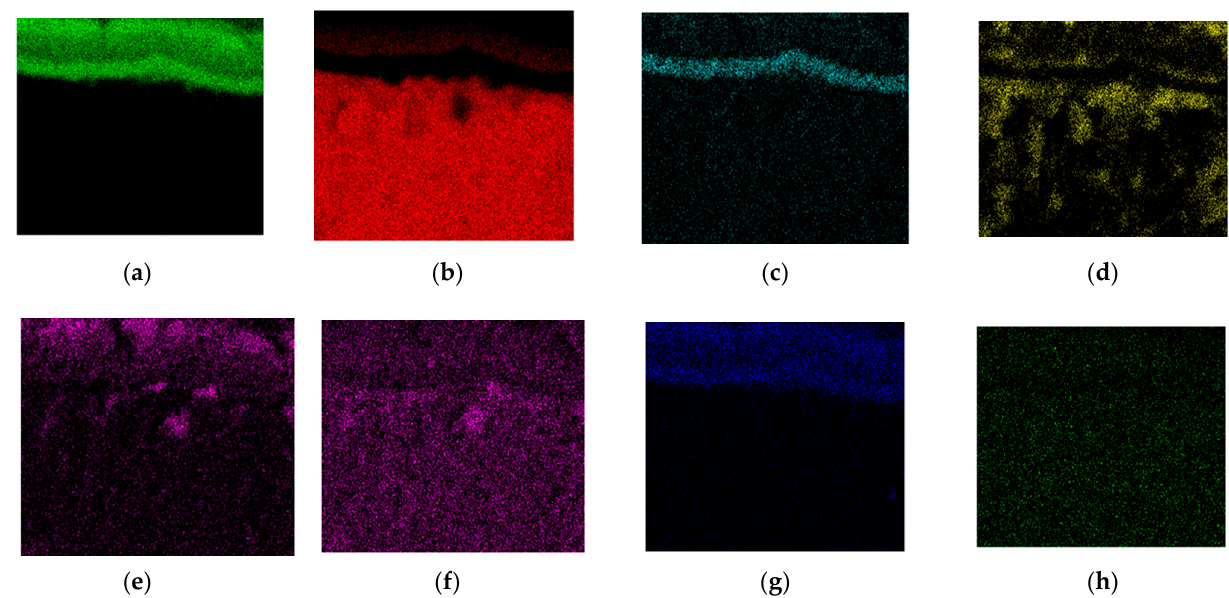
Figure 7. Distribution of elements along the plane of the section in the characteristic X-ray radiation of Cr ( a ), Fe ( b ), N ( c ), C ( d ), O ( e ), Si ( f ), Mn ( g ), and W ( h ) for steel DIN 105WCr6 after nitrogenchroming: nitriding (temperature—540 ◦ C, time—36 h) and chroming (temperature—1050 ◦ C, time—4 h).